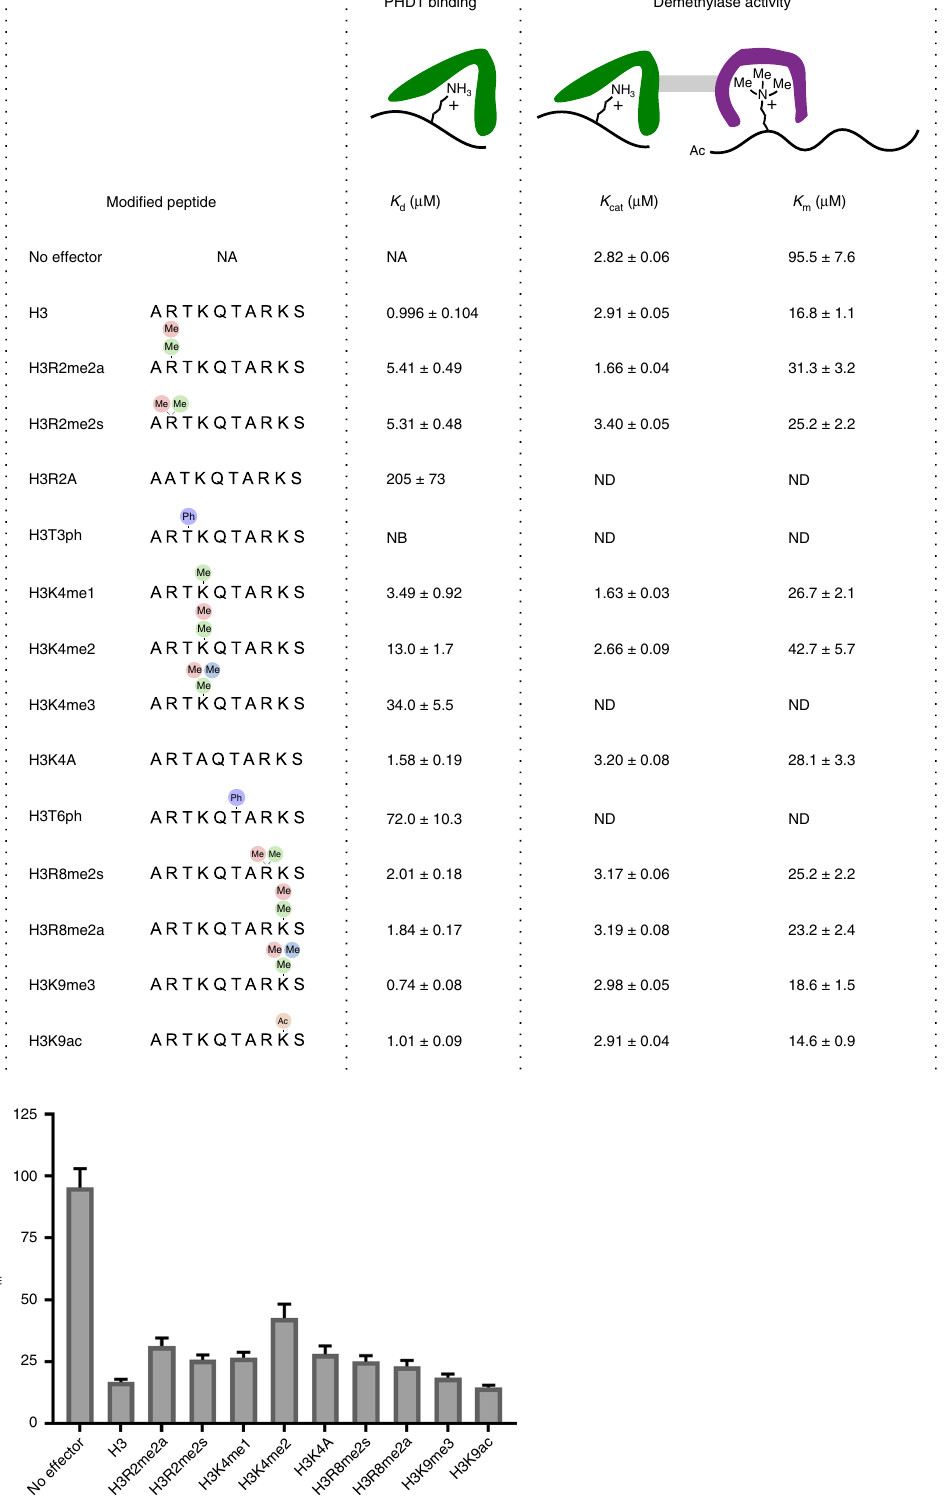
Fig. 4 H3 modi fi cations dictate demethylation activity enhancement in KDM5A. a Binding af fi nities ( K d ) of various modi fi ed H3 10mer N-terminal peptides for PHD1 and the Michaelis – Menten parameters ( k cat and K m ) for demethylation of Ac-H3K4me3 21mer substrate peptide in the presence of saturating concentrations of modi fi ed H3 10mer peptides. K d values were determined using a competition-based fl uorescence polarization assay, and kinetic parameters for demethylation were measured by the formaldehyde release assay. NB no binding, ND not determined. b Graphical representation of the K m values in the presence of saturating concentrations of differently modi fi ed effector peptides. Error bars refer to the standard deviation. Errors ( n ≥ 3) represent